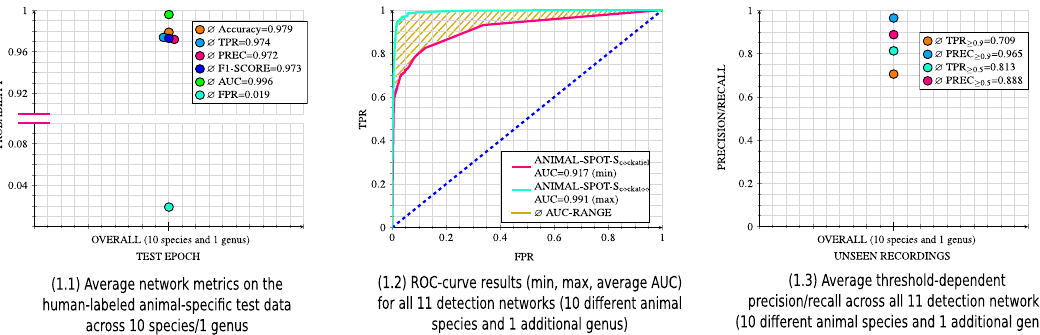
Figure 4. Overall summary across all 11 animal-specific segmentation models (10 different species, 1 additional genus), visualizing performance metrics with respect to the animal-specific, unseen, human-labeled test data ( 1.1 ), ROC-curves and AUC-Range ( 1.2 ), as well as threshold-dependent precision/recall values ( 1.3 ), both based on the animal-related unseen recording tapes (see also species-specific results in Supplementary Figs. S2–S12 and Supplementary Table S7) (created via Inkscape 39 , Version